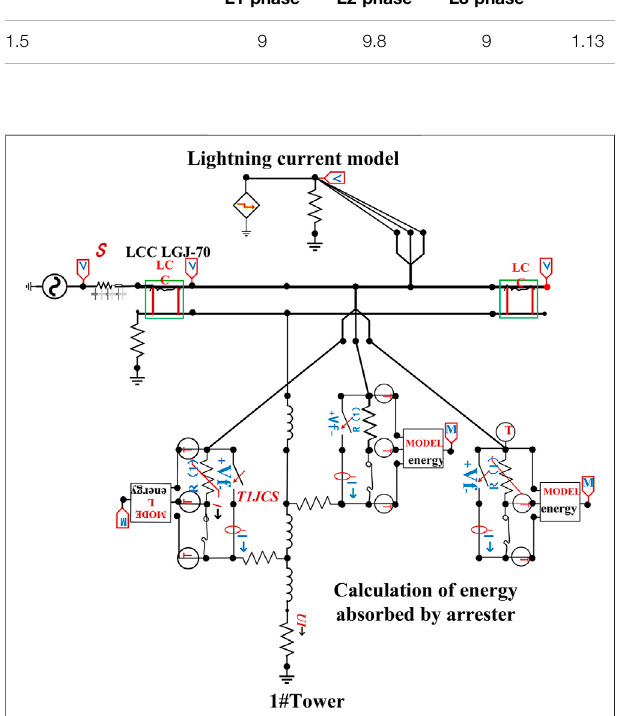
FIGURE 5 | Wiring diagram of double circuit line simulation calculation